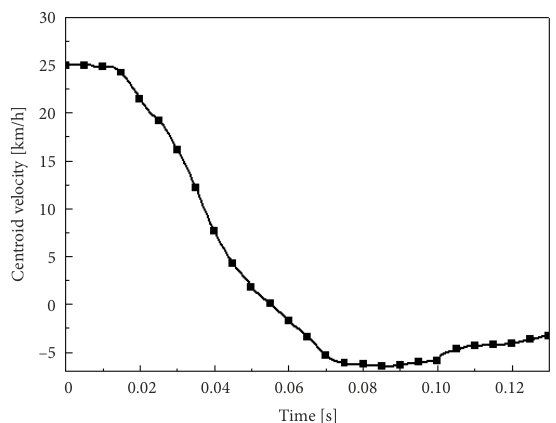
Figure 13. Transfer characteristic curve of the collision force